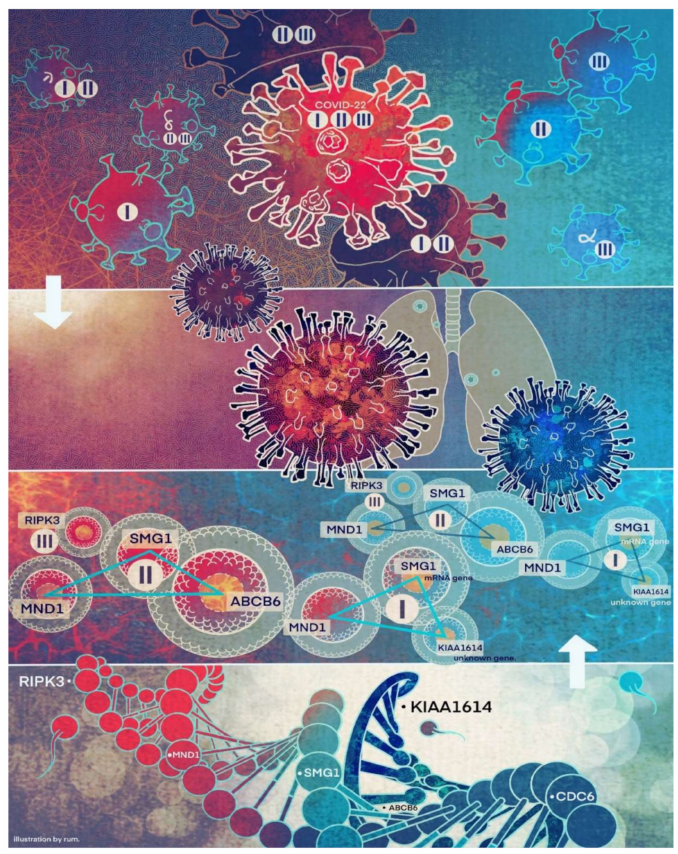
Figure 4. COVID-19 formation: a conceptual visualization of gene-gene relationship. Legend I stands for the signature formed by KIAA1614, MND1, and SMG1, legend II stands for the signature formed by ABCB6, MND1, and SMG1, and legend III stands for the signature formed by RIPK3. The author designed the concept and flowchart. Jing Zhang drew the